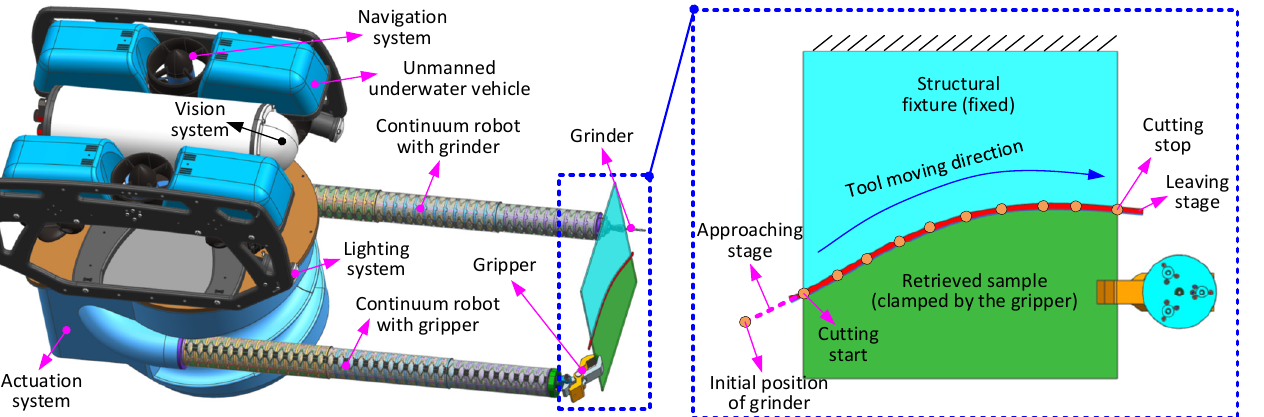
Figure 5. Operating principle of the dual-arm continuum robot in the remote sample removal case study. One arm with the gripper at the end holds the structure, while the other arm with the grinder moves along the planned path to cut the sample from the structure (see the enlarged